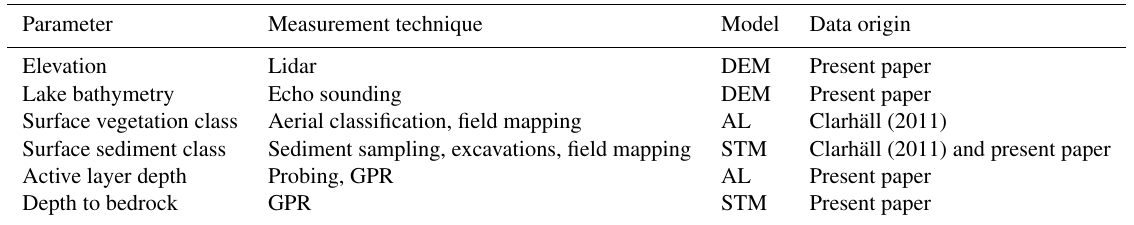
Figure 1. Map showing the location of the study site (Two Boat Lake), accessible from the nearby town of Kangerlussuaq (modified from Johansson et al., 2015). Table 1. List of equipment and in which resulting model the data are used. DEM: digital elevation model; AL: active layer model; STM: sediment thickness